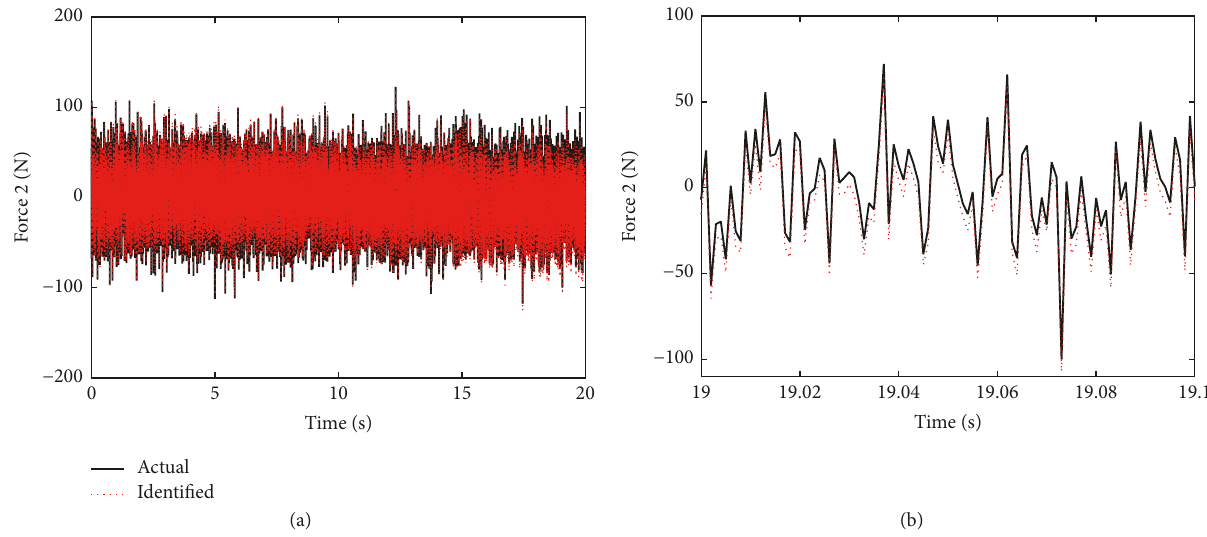
Figure 3: (a) The actual and identified results of force 𝑢 2 . (b) Zoom-in view of a segment (1–1.1s) of (a).